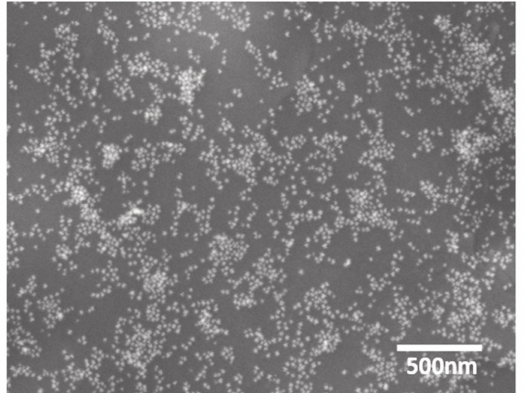
Figure 4. SEM images of SA-Au NPs showing the sphere-like shape of the prepared NPs measure at a resolution of 500 nm.